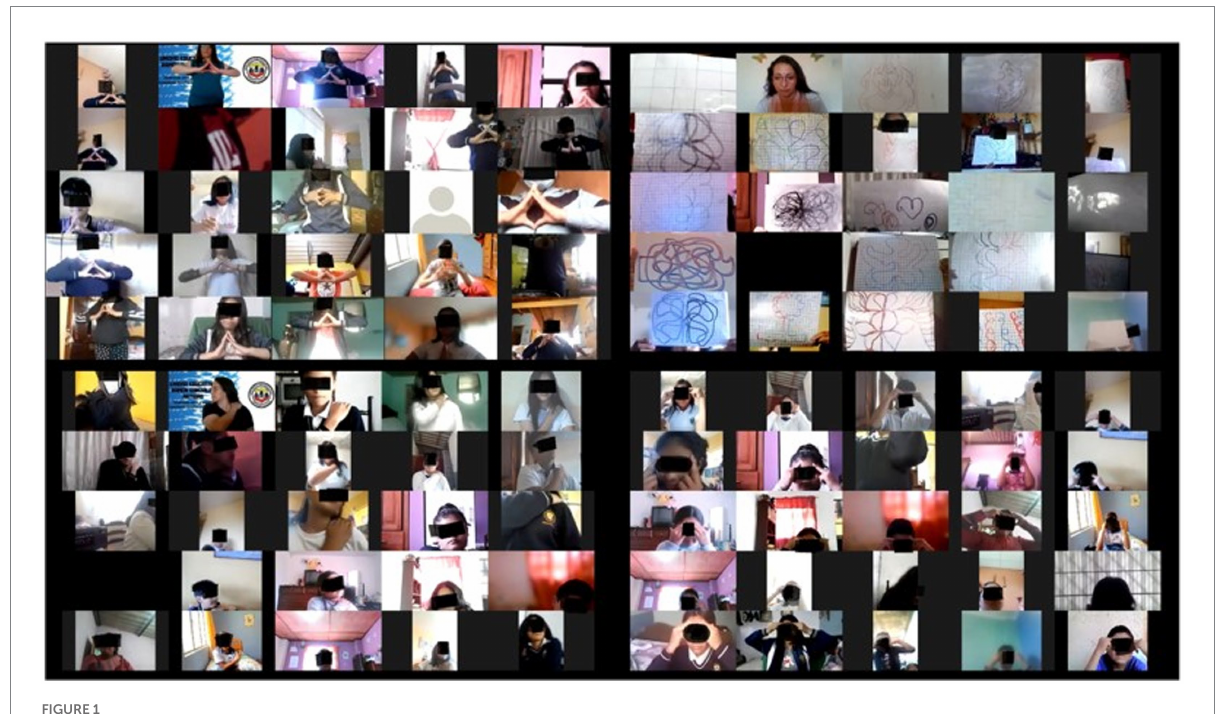
FIGURE 1 Execution of Brain Gym